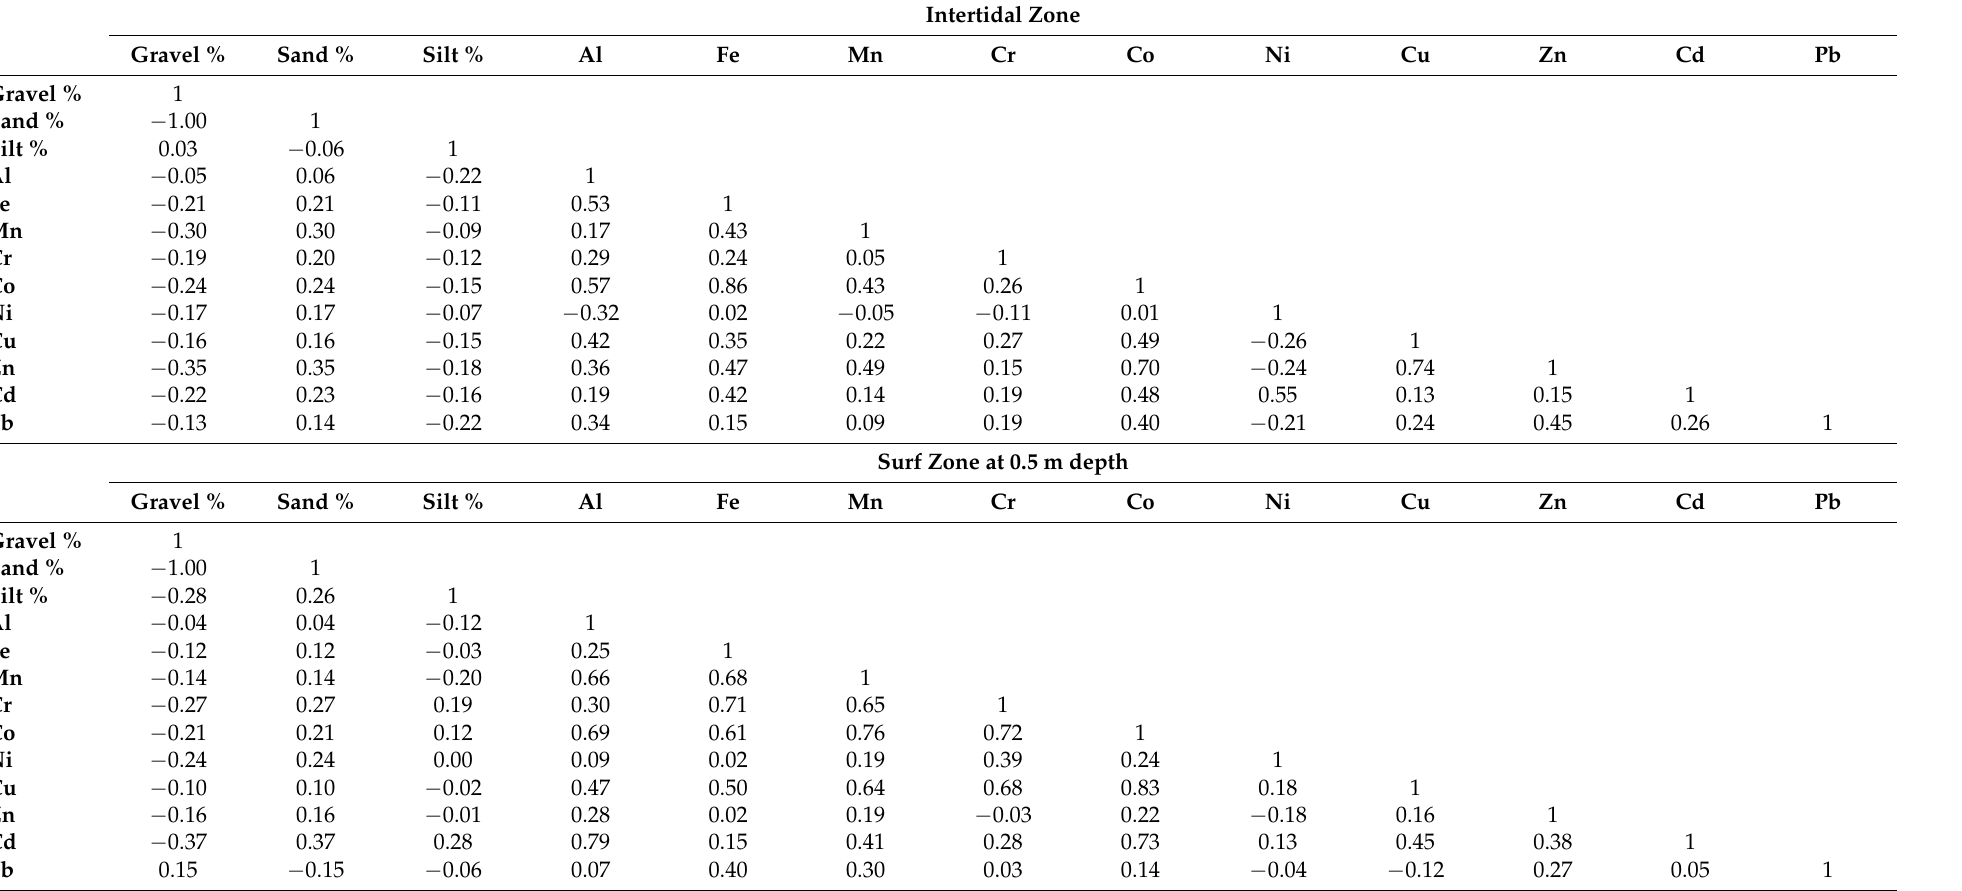
Table 4. Pearson correlation coefficient variables of heavy metals in surface sediments. Intertidal